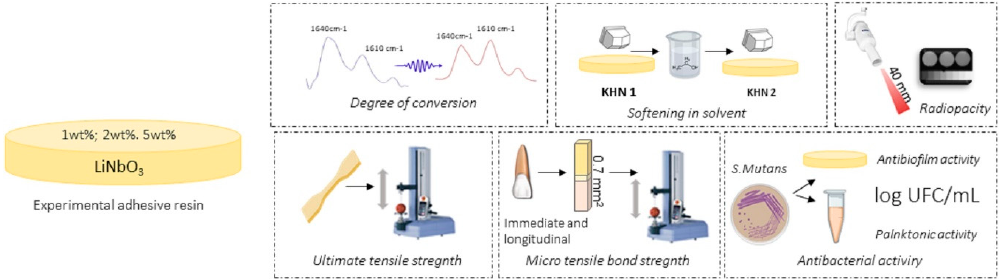
Figure 2. Illustrative image of the adhesives formulated, and methods applied to test the materials: degree of conversion, softening in solvent, radiopacity, ultimate tensile strength, immediate and longitudinal microtensile bond strength, and antibacterial